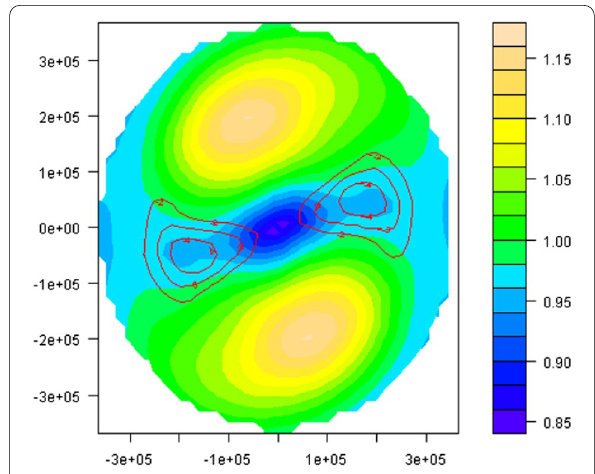
Fig. 2 Smoothed variogram of intra-event residuals of PGV at record stations of Anza